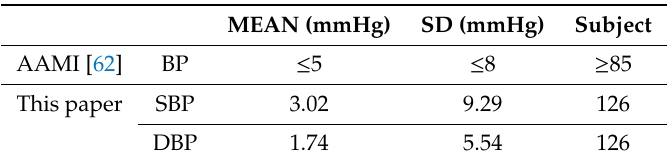
Table 13. Comparison of this paper results with the Association for the Advancement of Medical Instrumentation (AAMI) standard.